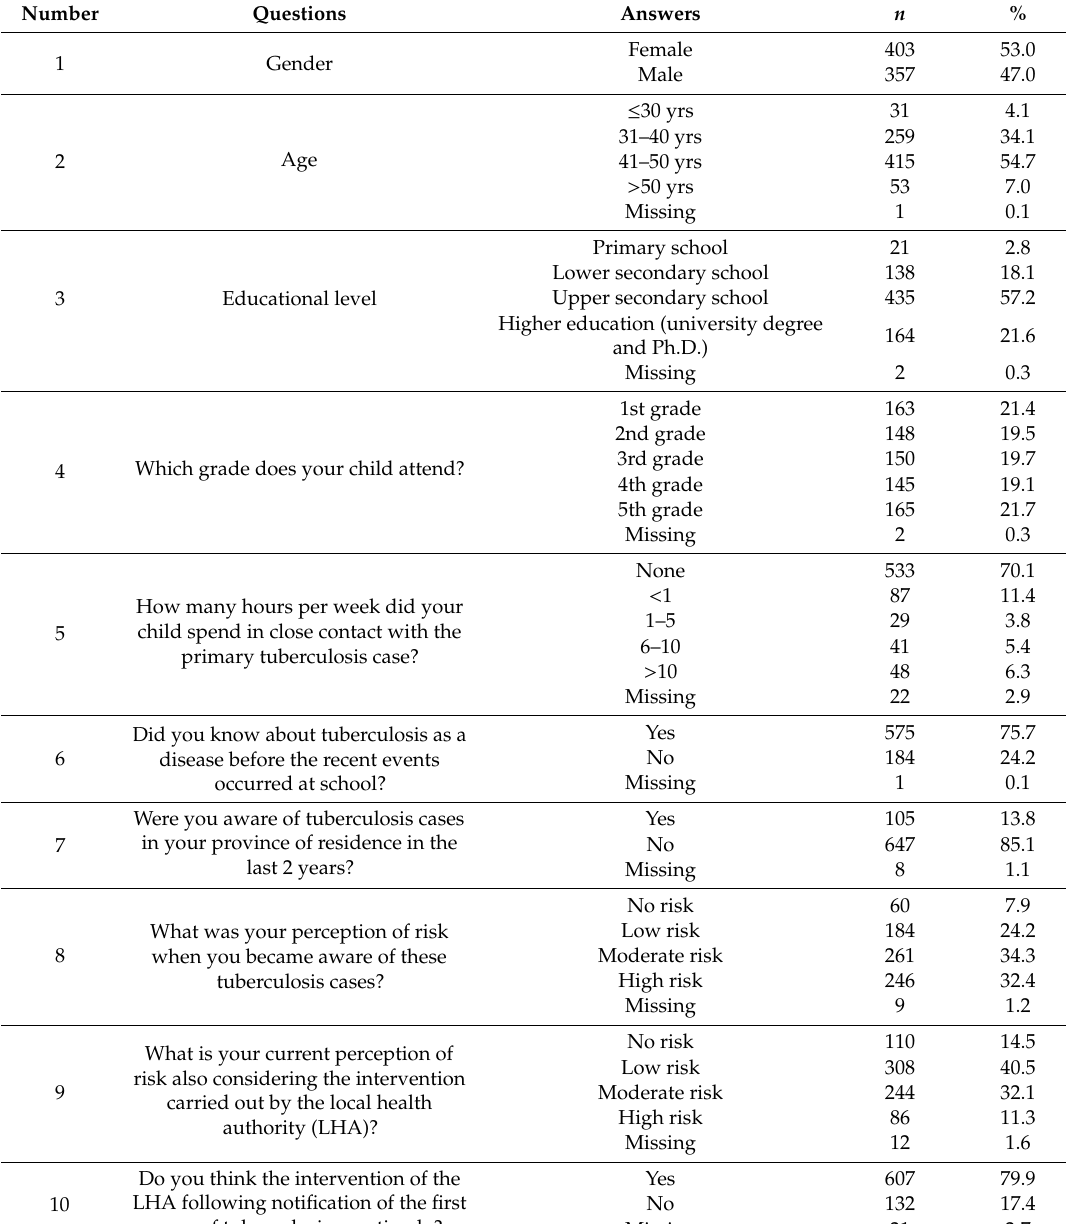
Table 1. Responses given by parents, risk perception questionnaire n =